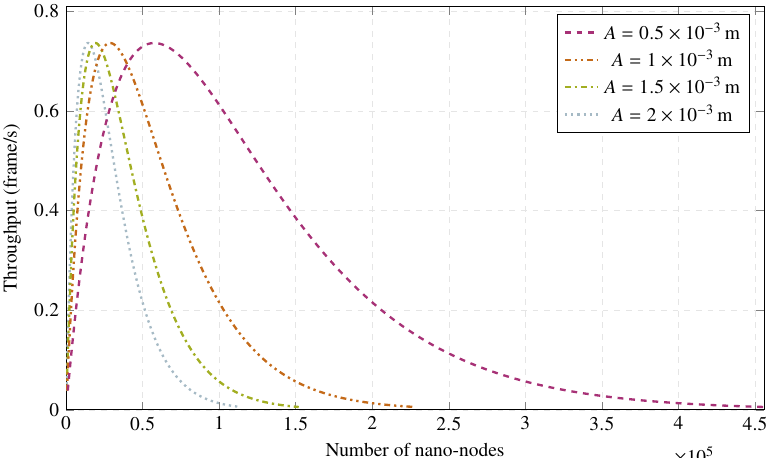
Figure 4. Influence of the length of the coverage area on network throughput for f = 1Hz, v = 0.24m / s, T = 60s, σ = 2, and t f =